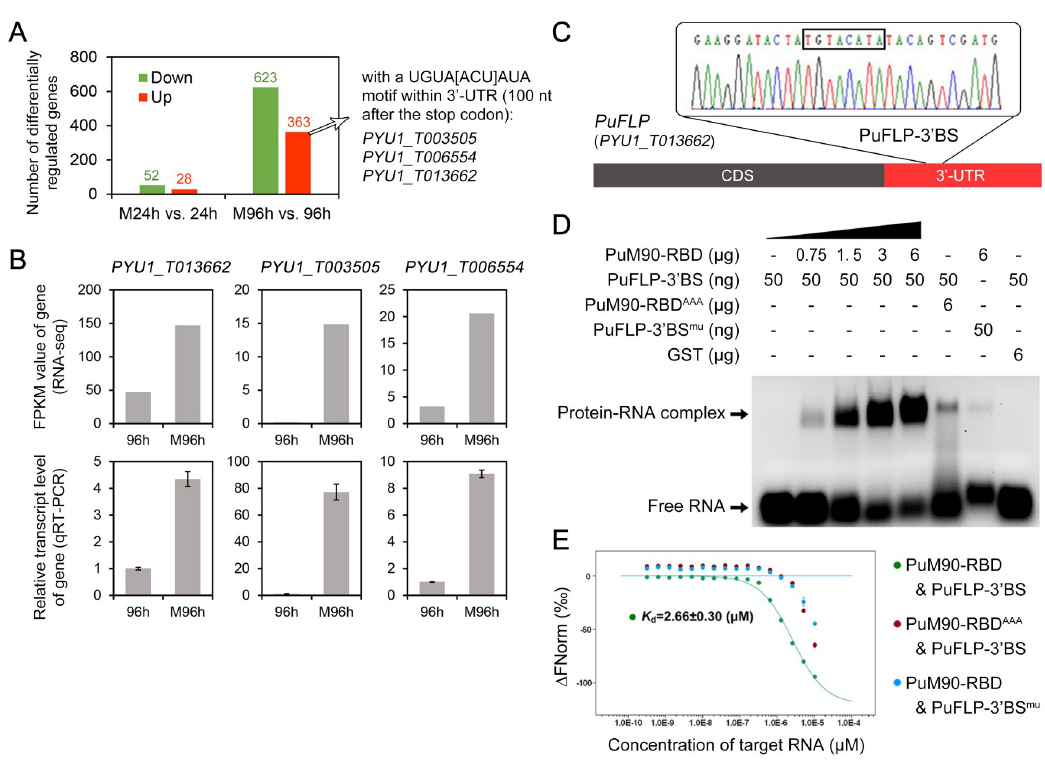
Fig 6. PuM90 binds to the 3 0 -UTR of PuFLP and represses PuFLP expression. (A) The number of differentially regulated genes between the PuM90 knockout mutant Δ PuM90-1 and WT at 24 h and 96 h. Three genes ( PYU1_T006554 , PYU1_T013662 , and PYU1_T003505 ) were upregulated in the mutants compared to the WT at 96 h and also contained the UGUA[A/U/C]AUA motif in their 3 0 -UTRs. (B) Transcript levels of the three candidate genes measured through RNA-seq and qRT-PCR. (C) Sanger sequencing trace of the 30-nt PuFLP -3 0 BS used for the electrophoretic mobility shift assay (EMSA) assay. The UGUACAUA core binding motif is indicated with a black box. (D) EMSA results showing that PuM90-RBD bound to PuFLP-3 0 BS, while PuM90-RBD AAA or GST did not bind to PuFLP-3 0 BS, and PuM90-RBD did not bind to PuFLP-3 0 BS mu . (E) Microscale thermophoresis (MST) results showing that PuM90-RBD bound to PuFLP-3 0 BS ( K d = 2.66 μ M, green trace), while PuM90-RBD AAA did not bind to PuFLP 3 0 BS ( K d = 0 μ M, red trace), and PuM90-RBD did not bind to PuFLP-3 0 BS mu ( K d = 0 μ M, blue trace).